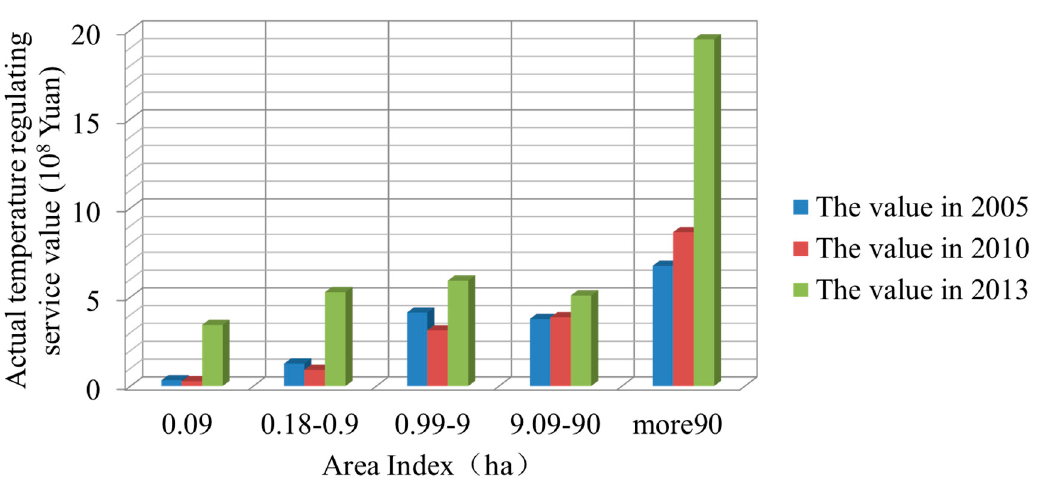
Figure 4. Actual temperature regulating service value of “source” landscape in 2005, 2010, and 2013 with different patch areas.